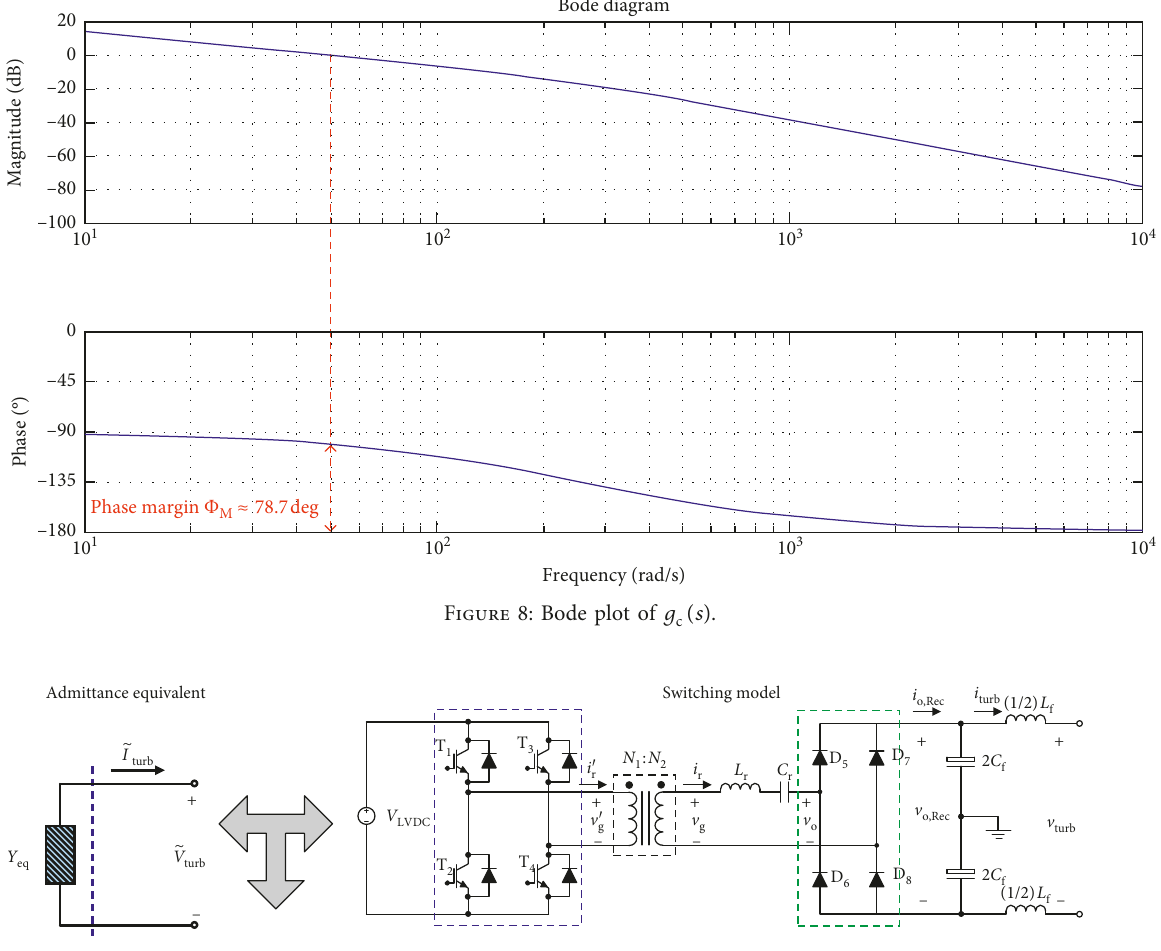
Figure 9: Study case of DC collection network for one single cluster of wind turbines with the proposed harmonic model (admittance equivalent) of series resonant converter SRC# (DC wind turbine generator, WTG) with the output filter included ( L harmonic susceptibility study.